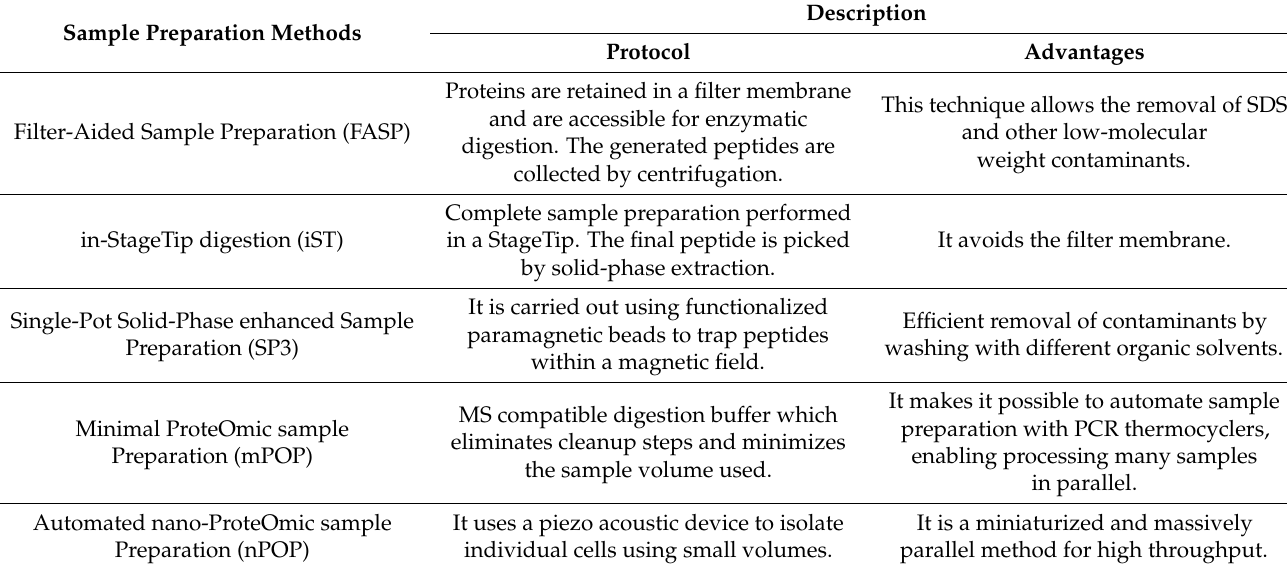
Table 1. Main sample preparation methods used in single-cell